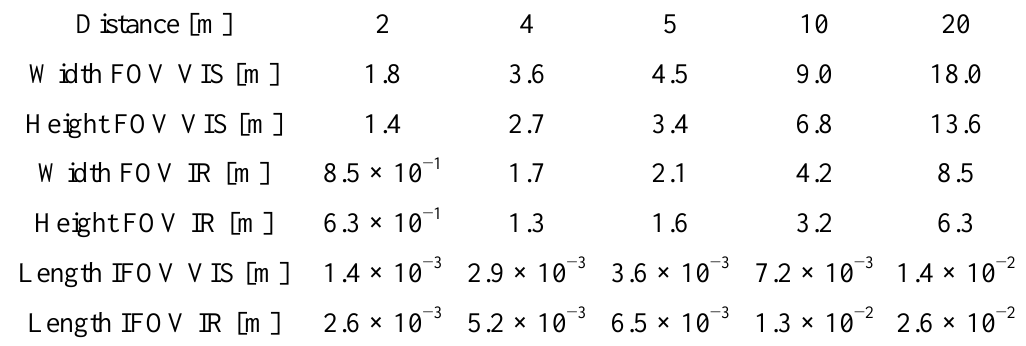
Table 2. Linear dimensions corresponding to FOV and IFOV at different